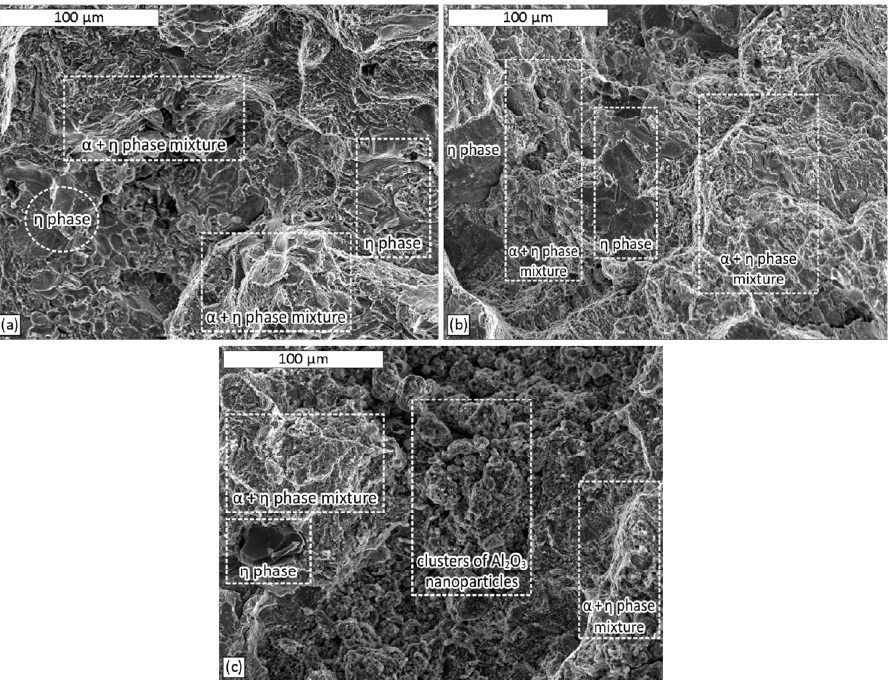
Fig. 2 Fracture surface of nanocomposites with 0.3 wt.% nanoparticles: (a) nanocomposite N2: 0.3-50, (b) nanocomposite N5: 0.3-25, and (c) nanocomposite N8: